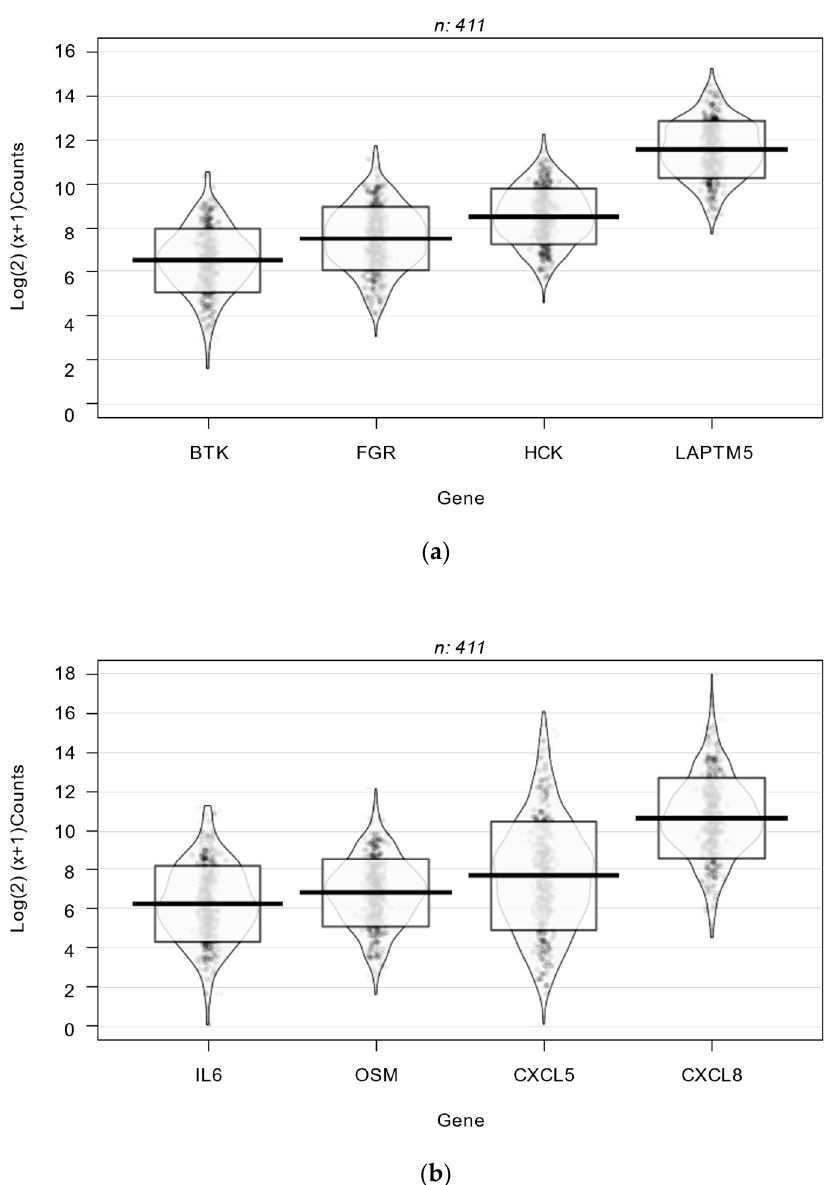
Figure 2. Violin density plots of the expression of inflammation-correlated genes of the Src and JAK STAT signaling pathways. ( a ) Src Genes; ( b ) JAK STAT Genes. STAT signaling pathways. ( a ) Src Genes; ( b ) JAK STAT